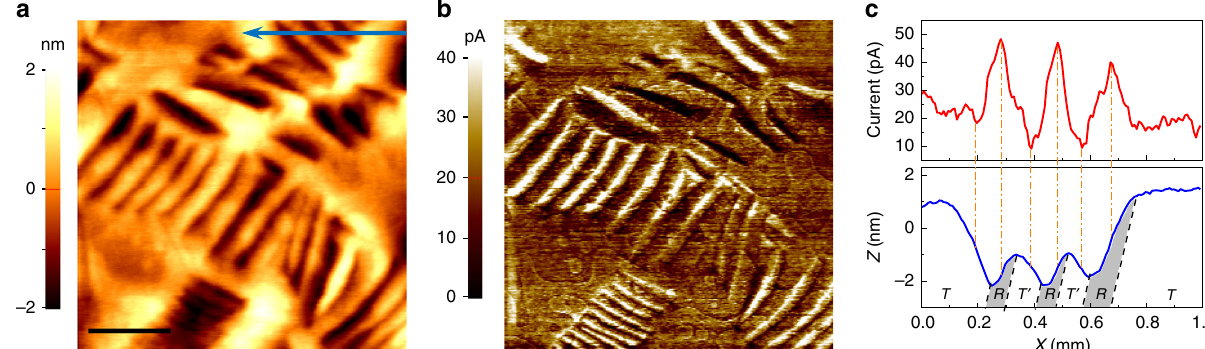
Fig. 2 Spatially resolved photocurrent distribution. a Surface topography and b photocurrent distribution characterized under illumination on a 100 nm- thick BiFeO 3 /LaAlO 3 thin fi lm; Scale bar 500 nm. c Pro fi le comparison between the photocurrent and surface morphology of the area marked by blue arrow in (a). The photocurrent is acquired under the illumination of 405 nm light with an intensity of 1 W cm − 2 . The bias is applied to a side Pt electrode evaporated on the surface of the BiFeO 3 fi lm with the conductive tip virtually